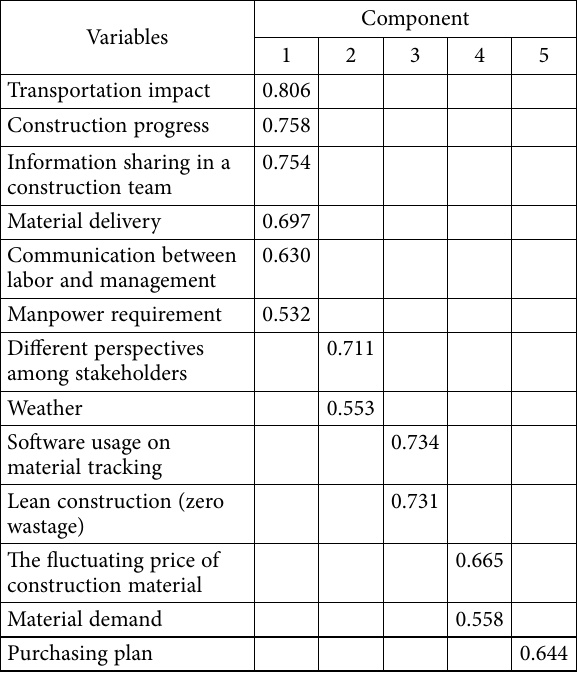
Table 5. The second rotated component matrix Variables